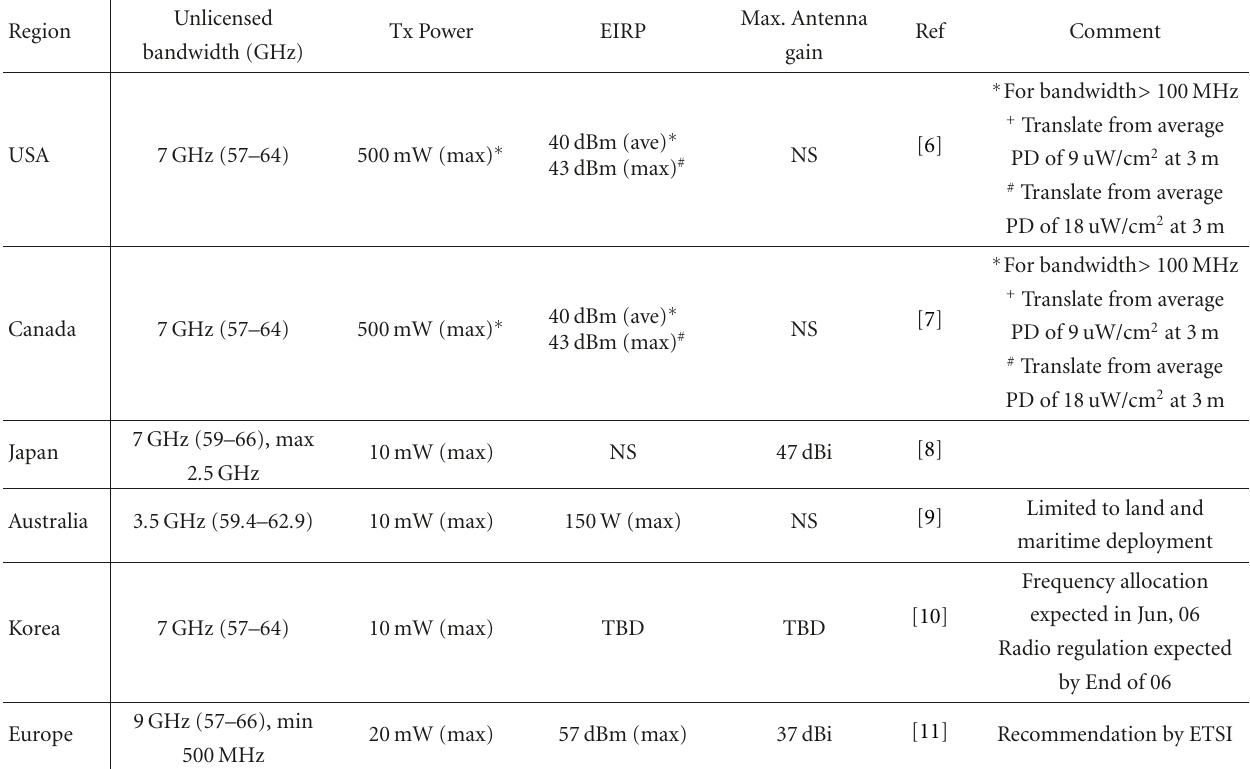
Max. Antenna Ref Comment